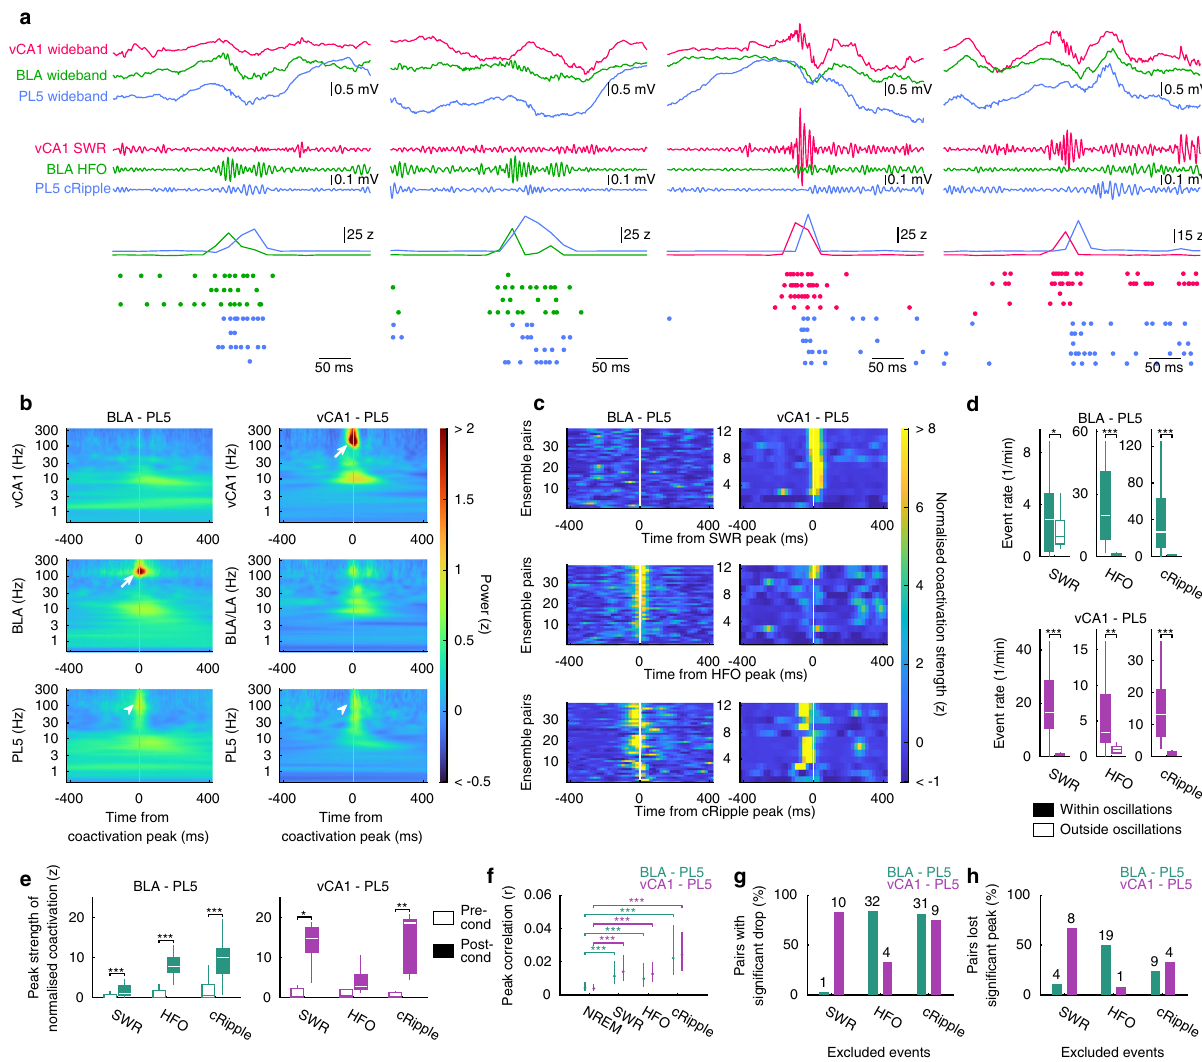
Fig. 4 HFOs, SWRs, and cRipples are associated with inter-regional ensemble coactivations during NREM. a Representative examples of BLA – PL5 coactivation (left two panels) and vCA1 – PL5 coactivation (right two panels). Wideband and fi ltered LFP recorded from vCA1, BLA, and PL5 are shown at the top. The instantaneous ensemble activation strength and spikes from member cells of the ensembles are shown at the bottom. b BLA – PL5 and vCA1 – PL5 coactivation-triggered average of LFP wavelet powers during post-cond NREM. Peaks corresponding to HFOs and SWRs (white arrows) are observed at the BLA – PL5 and vCA1 – PL5 coactivations, respectively, and peaks re fl ecting cRipples (white arrowhead) are apparent at the coactivations of both region pairs. c Oscillatory event peak-triggered average BLA – PL5 and vCA1 – PL5 coactivation strength. The BLA – PL5 and vCA1 – PL5 ensemble pairs are sorted based on the peak height around time 0 of HFO- and SWR- triggered averages, respectively. d , e Box plots indicate coactivation event rates within/outside oscillatory events during post-cond NREM ( d ) and the coactivation strength peaks within oscillatory events during pre- and post-cond NREM ( e ). The centre lines and limits of the boxes represent median and quartiles, respectively, and whiskers extend to the maxima and minima with outliers excluded. *** p < 0.001, ** p < 0.01, * p < 0.05, WSR-test. f Median of peak correlation between ensemble pairs (including non-coupled pairs) within oscillatory events in post-cond NREM. Error bars indicate quartiles. *** p < 0.001, ** p < 0.01, * p < 0.05, post hoc TK test following the Friedman test. Only statistical results of comparisons with the entire NREM are shown. g , h Proportions of coupled-ensemble-pairs that signi fi cantly (p < 0.01, random jittering analysis) reduced CCG peak height ( g ) and proportions of coupled-ensemble-pairs that lost signi fi cant peaks on CCG ( h ) by excluding the time bins containing SWRs, HFOs, or cRipples. The numbers of pairs are superimposed on the top of the bars. The numbers of pairs analysed in ( b – h ) are summarised in Supplementary Table 4. Detailed statistics are shown in Supplementary Data 1. Source data are provided as a Source Data fi